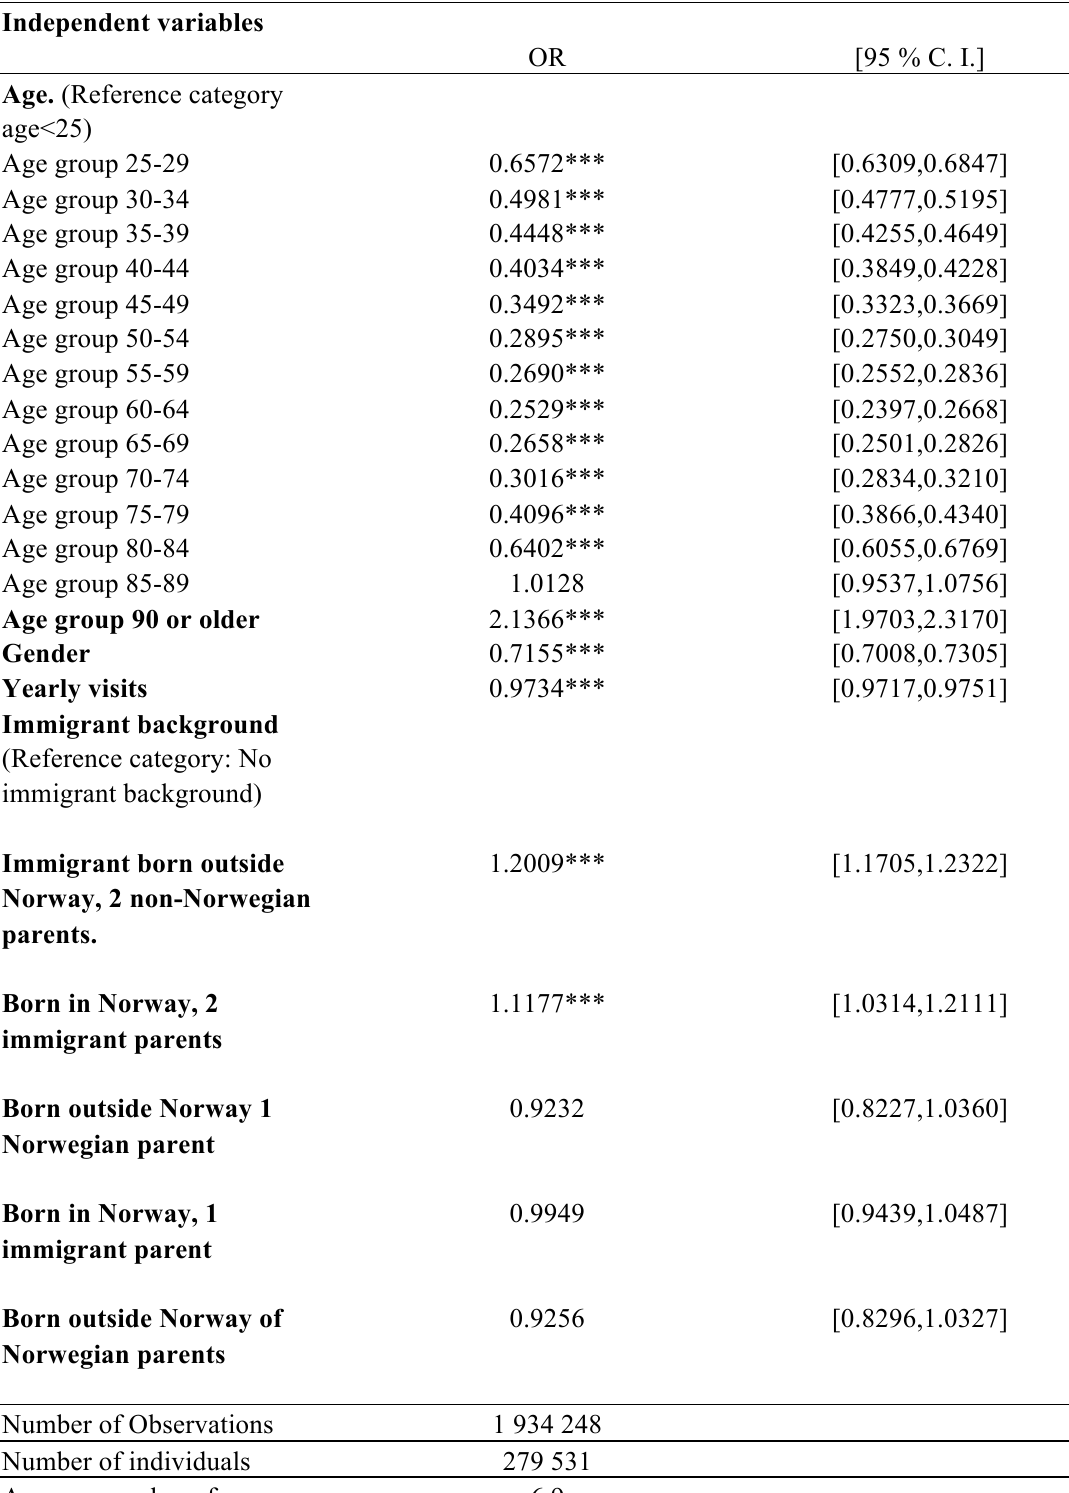
Table 2: The estimated impact of individual characteristics on the probability of seeking care at the EW. Results from random effects logistic regression Independent variables OR [95 % C.